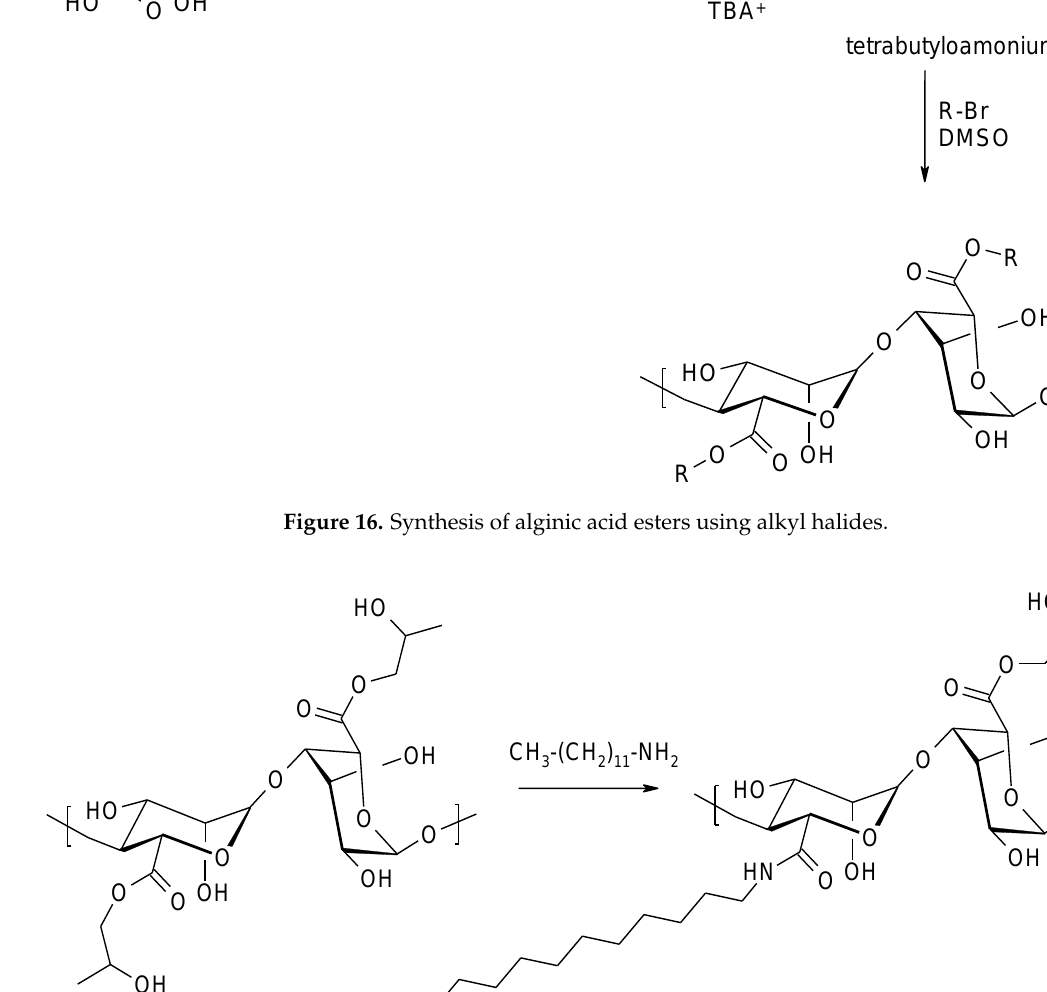
+ Figure 18. Formation of N -octylamide of alginic acid using EDC as a condensing agent. Water-soluble EDC-HCl has been used to obtain a variety of amide derivatives of alginic acid [112–116]. The attachment of highly hydrophobic amines ( N -dodecylamine) to alginates leads to amphiphilic materials. The physicochemical properties of the materials result from the hydrophobic nature of the amide substituent and the hydrophilic nature of the polysac- charide matrix. Furthermore, 2-chloro-1-methylpyridinium iodide (CMPI) was used as the condensing reagent [117].